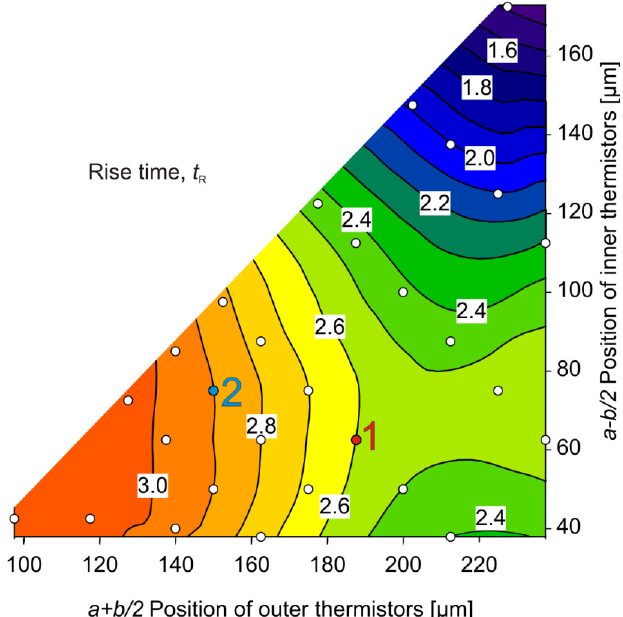
Figure 14. Contour plot of the 10%–90% rise time t